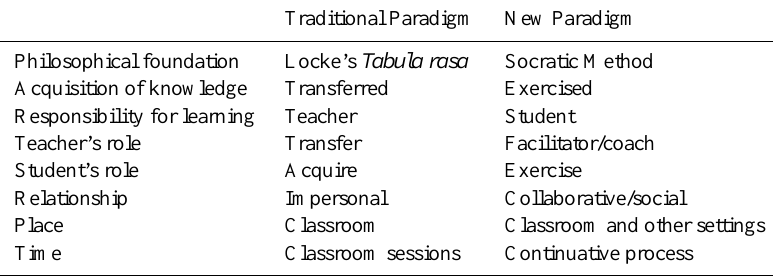
Table 1. Paradigm shift in teaching and learning